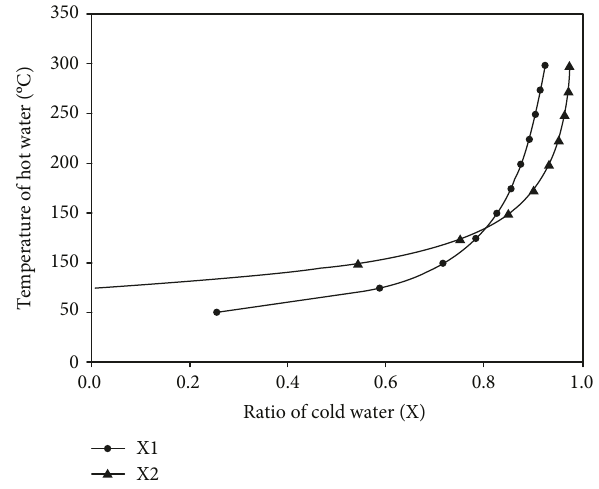
Figure 5: Relationship between temperature of hot water and